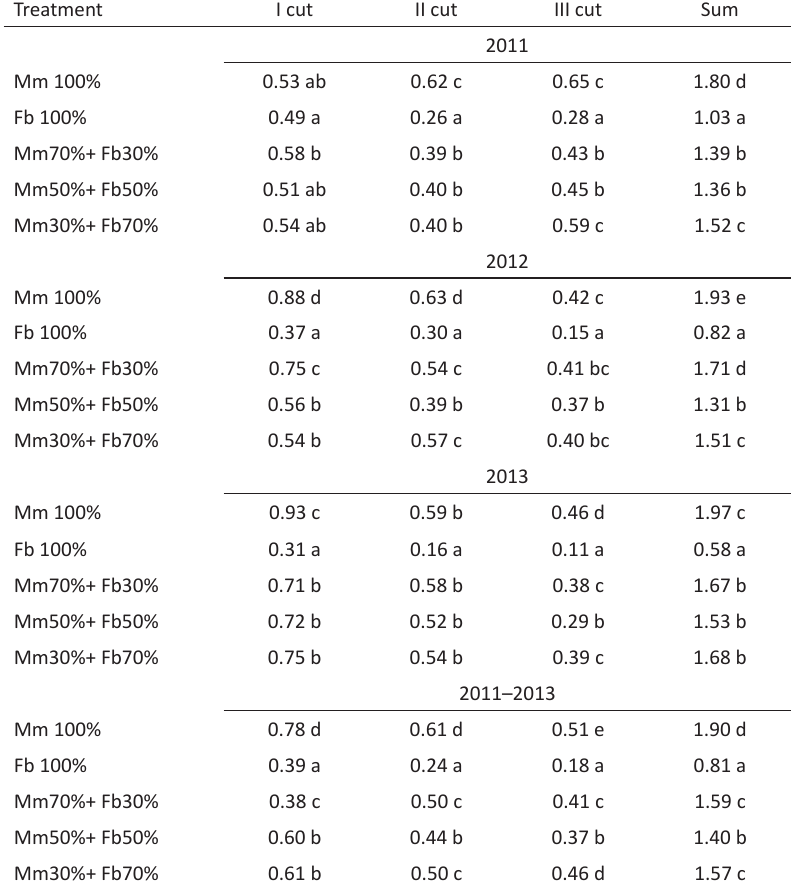
Table 3. Total protein yield (Mg ha -1 ) Treatment I